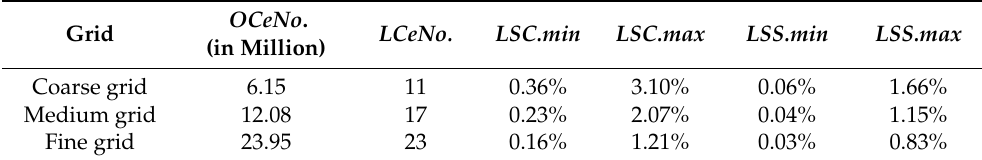
Table 1. Important parameters for different sets of grids.